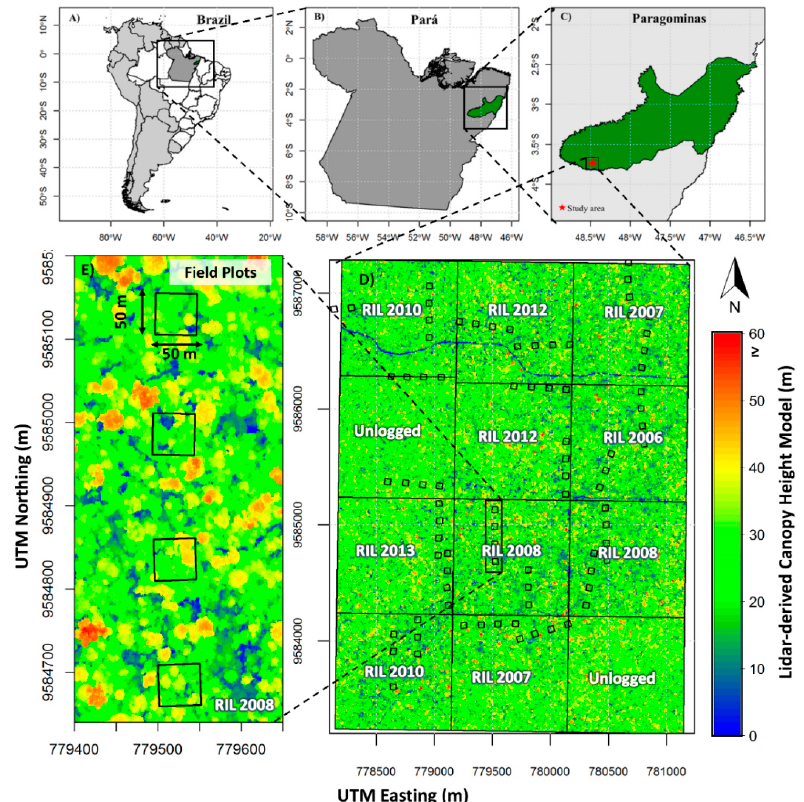
Figure 1. Location of the study area. ( A ) South America and Brazil; ( B ) States of Pará and Paragominas city; ( C ) Paragominas city; ( D ) Airborne lidar coverage; ( E ) Field plots on the lidar-derived CHM. Reduced-impact logging (RIL).